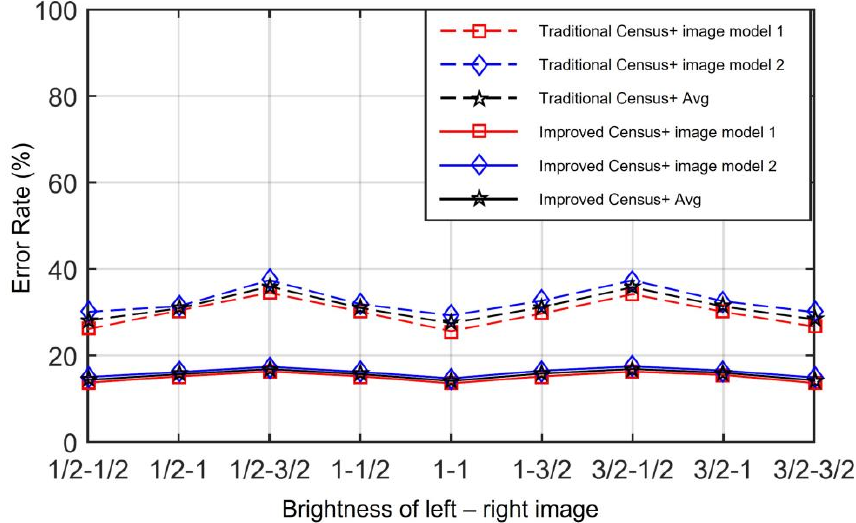
Figure 3. Left and right images of three different brightness cardiac models. ( a ) 1/2 brightness left and right images; ( b ) original brightness left and right images; ( c ) 3/2 brightness left and right images The mismatching rates of the disparity map corresponding to the traditional census and the improved census are counted, respectively, as shown in Table 1.